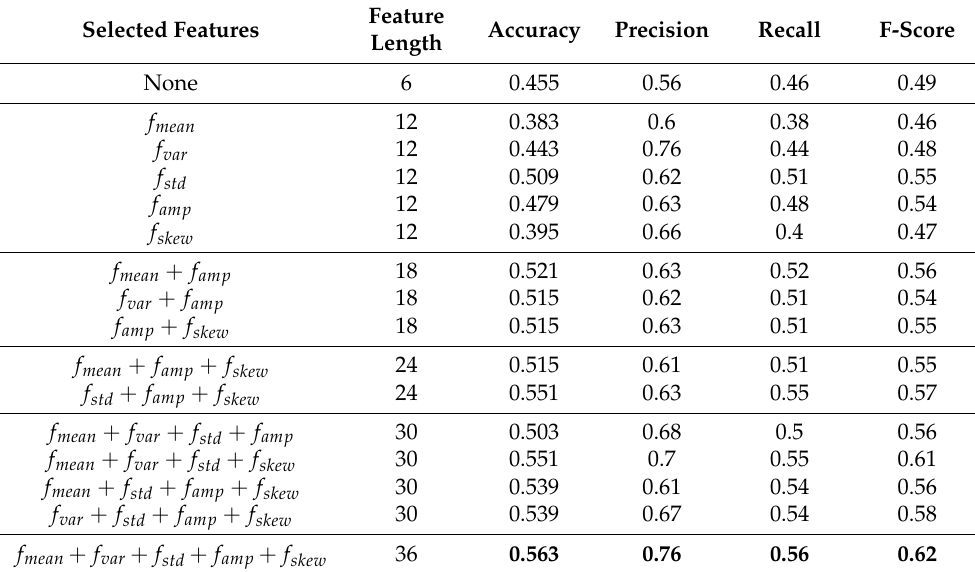
Table 6. Results of behavior recognition performance evaluation by selected features using sen- sor